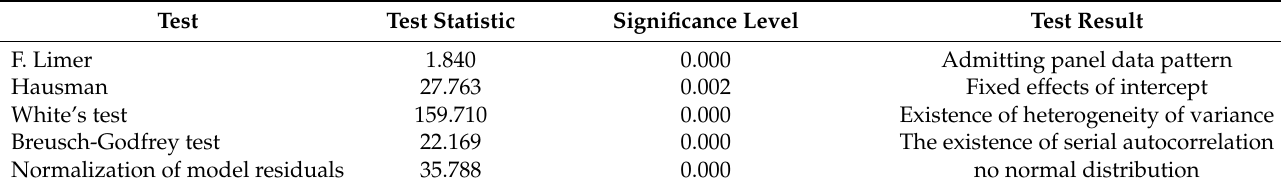
Table 5. The results of the classic regression hypothesis